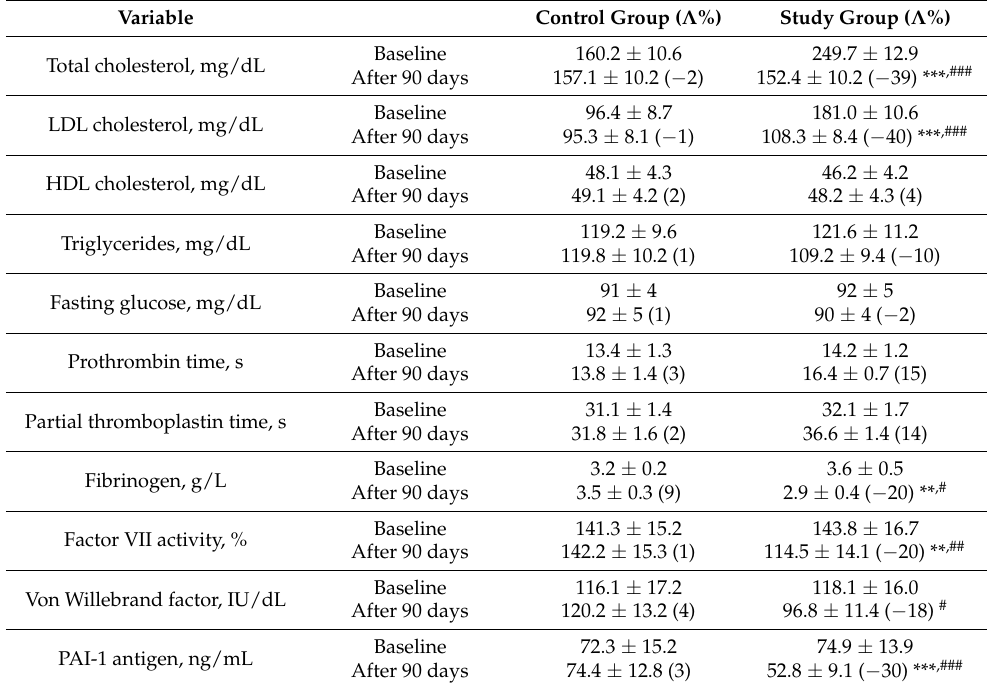
Table 2. Effect of PCSK9-inhibitor on plasma lipids, glucose, fibrinolysis, and coagulation in patients with isolated